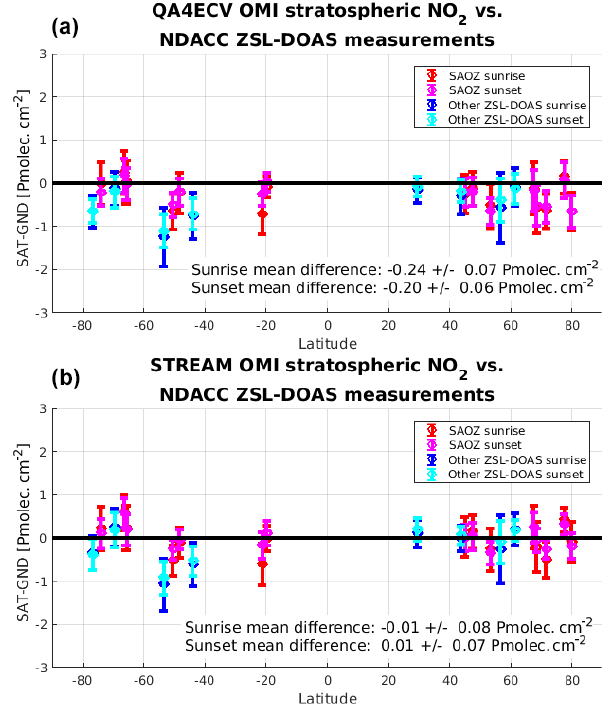
Figure 7. Meridian dependence of the mean (the circular markers) and standard deviation ( ± 1 σ error bars) of the individual differ- ences between QA4ECV (a) and STREAM (b) OMI stratospheric NO 2 column data and ZSL-DOAS reference data represented at in- dividual stations from the Antarctic to the Arctic. The values in the legend correspond to the mean and standard error of all mean (for each station)